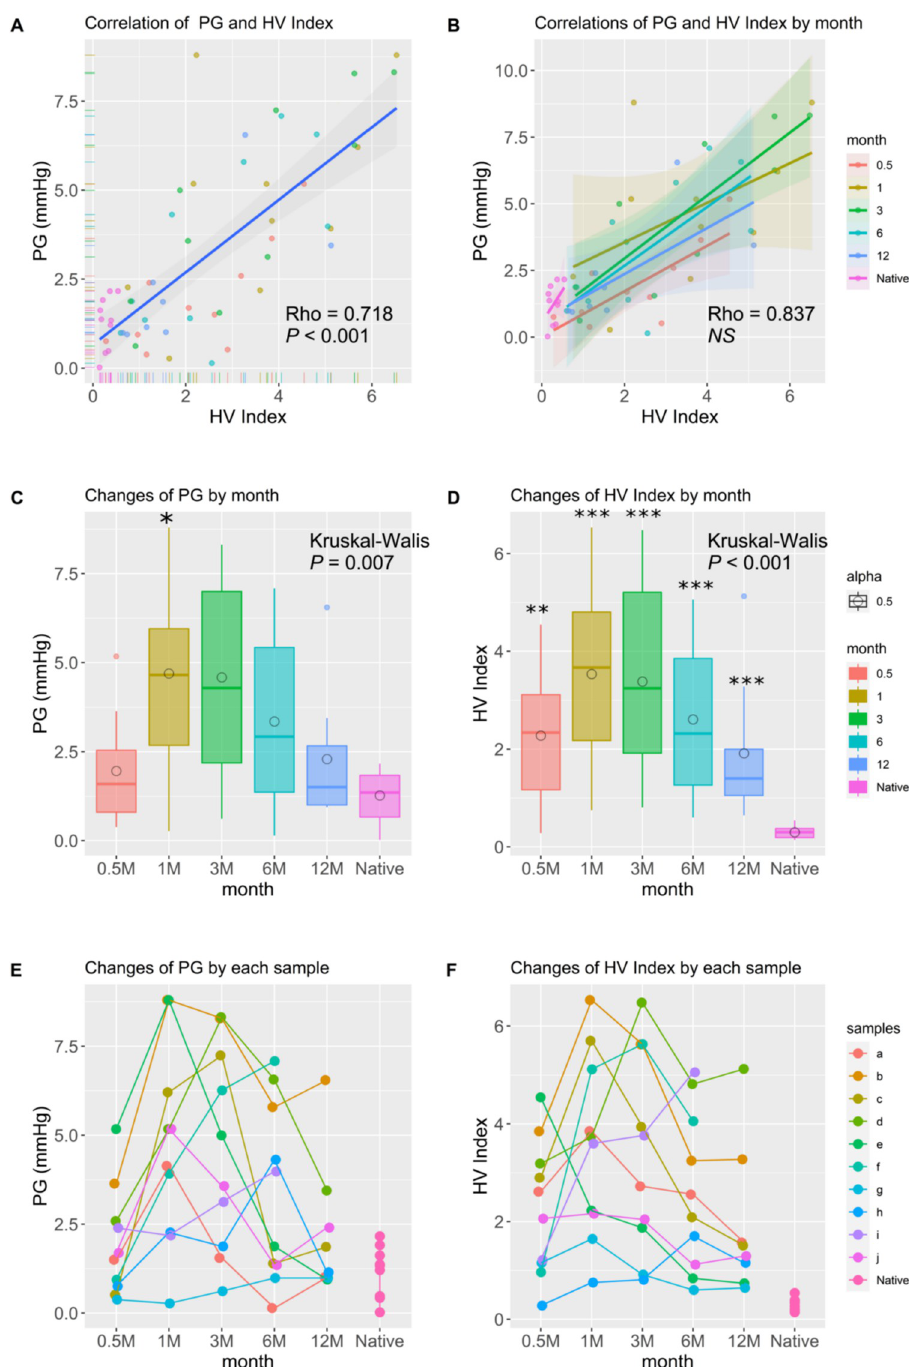
Fig 3. (A) Correlation between hepatic vein (HV) index and pressure gradient. Spearman’s rank correlation Rho value of the HV index is shown. Rho = 0.718 (95% confidence interval: 0.564, 0.826; P < 0.001). (B) Correlation between HV index and pressure gradient by month. In native IVC, Rho = 0.370, and in iTEV at 0.5 months, Rho = 0.709; at 1 month, Rho = 0.540; at 3 months, Rho = 0.794; at 6 months, Rho = 0.600; and at 12 months, Rho = 0.786. There was no difference in the correlation between months ( P = 0.784, NS: not significant). (C and D) Changes in pressure gradient (C) and HV index (D) by month expressed as box and whisker plots. Lines represent the lower, median, and upper quartile values. Whiskers represent the extent of the remaining data. Circles represent mean values. Pressure gradient, P = 0.007; HV index, P < 0.001 using the Kruskal–Wallis test. The Steel–Dwass test was used for posthoc analysis. (C) Native vs. 1 month ( � , P = 0.024). (D) Native vs. 0.5 months ( �� , P = 0.003); native vs. 1 month ( ��� , P = 0.0002);